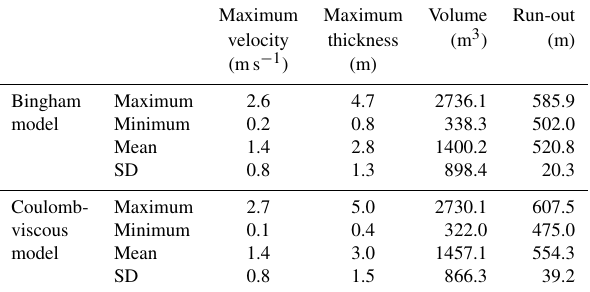
Table 3. Statistical summary for the 180 simulations performed with Bingham and Coulomb-viscous models for